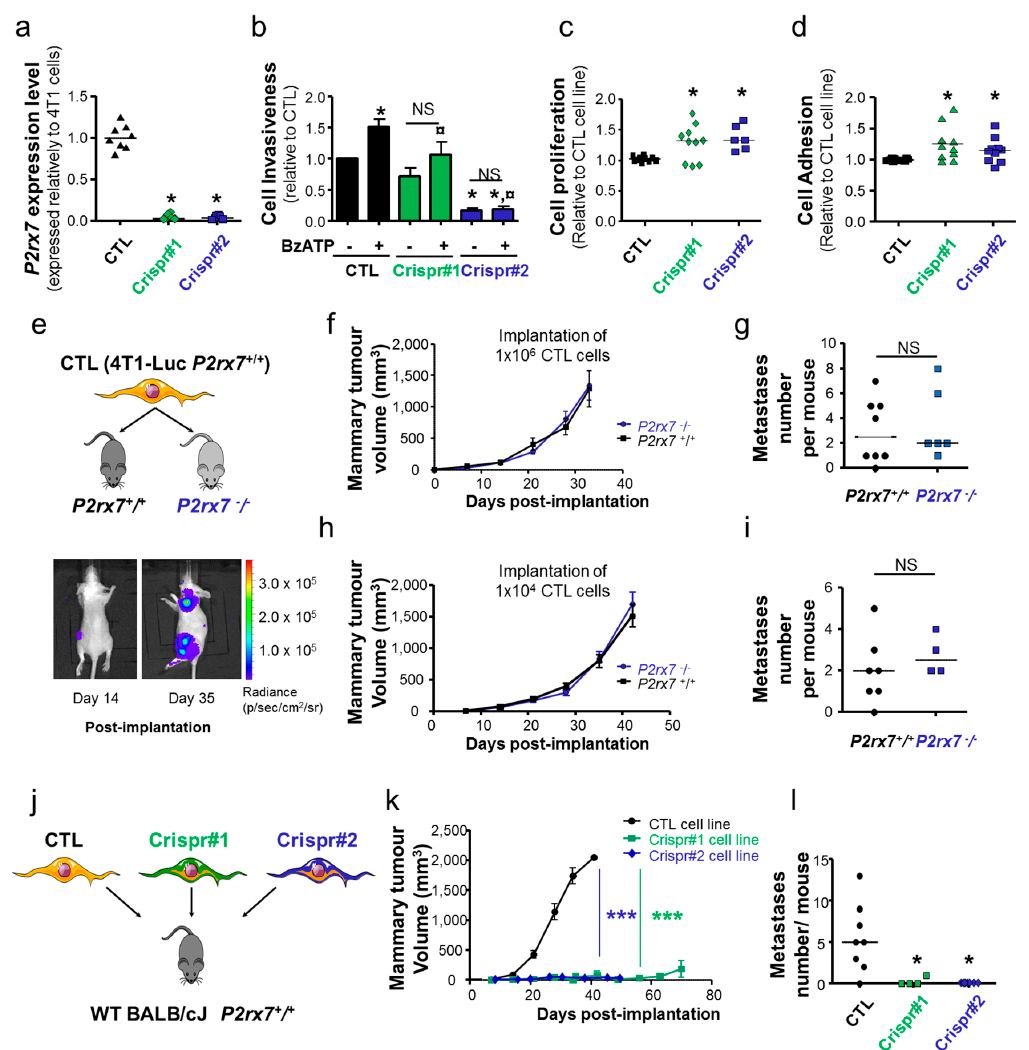
Figure 4. P2X7 receptor in mammary cancer cells enhances primary tumour growth and metastatic development in vivo. ( a ) P2rx7 mRNA expression levels assessed by RT-qPCR in CTL, Crispr#1 and Crispr#2 cell lines, expressed relatively to 4T1 cells. * indicated a statistically significant difference from CTL cells at p < 0.05 using Mann-Whitney Rank sum test. ( b ) 2-D cancer cell invasiveness of CTL, Crispr#1 and Crispr#2 cell lines, in the absence or presence of 300 µM BzATP, expressed relatively to the CTL cell line without BzATP ( n = 5–8 independent experiments). * indicates a statistically significant difference from CTL/no BzATP condition at p < 0.05, ¤ indicates a statistically significant difference from CTL/BzATP at p < 0.05, using Dunn’s Multiple Comparison Test. NS, stands for no statistically significant difference. ( c ) Cell proliferation over 4 days of CTL, Crispr#1 and Crispr#2 cell lines in the absence of 300 µM BzATP, expressed relatively to the CTL condition. Results are from 6–10 independent experiments. * indicates a statistically significant difference from CTL at p < 0.05 using Dunn’s Multiple Comparison Test. ( d ) Cell adhesion of CTL, Crispr#1 and Crispr#2 clones, expressed relatively to CTL. Results are from 10 independent experiments. * indicates a statistically significant difference from CTL at p < 0.05 using Dunn’s Multiple Comparison Test. ( e–i ) In vivo mouse experiments testing the effect of P2rx7 gene expression in host mice on primary tumour growth and metastasis development, with two numbers of cancer cells implanted. ( e ) Top, cartoon describing the experimental procedure, in which CTL cells, derived from 4T1-Luc expressing P2rx7 gene, were implanted to the fifth mammary fat pad of 6 weeks-old female wild-type BALB/cJ ( P2rx7 + / + ) or P2X7 knock-out BALB/cJ (P2rx7 − / − ) mice. Bottom, representative bioluminescent images of a wild-type mouse, on 14 and 35 days after cell implantation, identifying primary tumours as well as metastatic